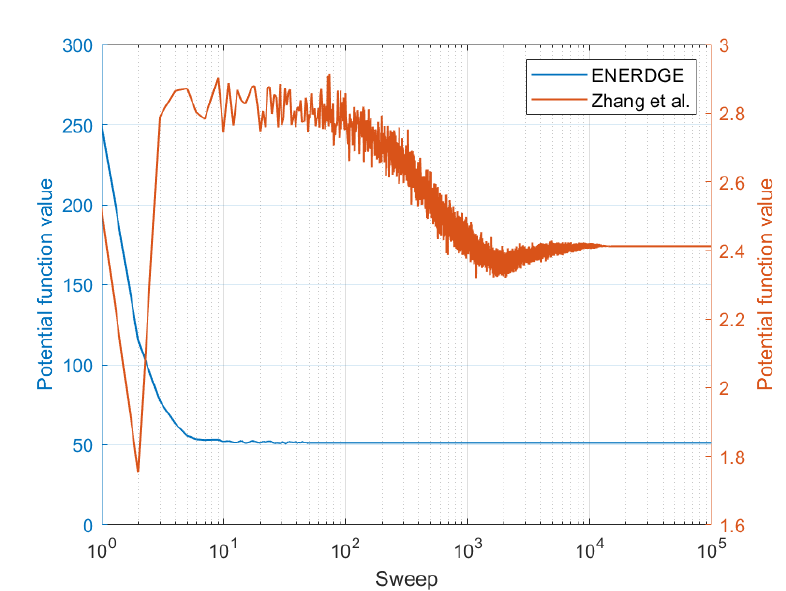
Figure 14. Comparison of the workload redistribution